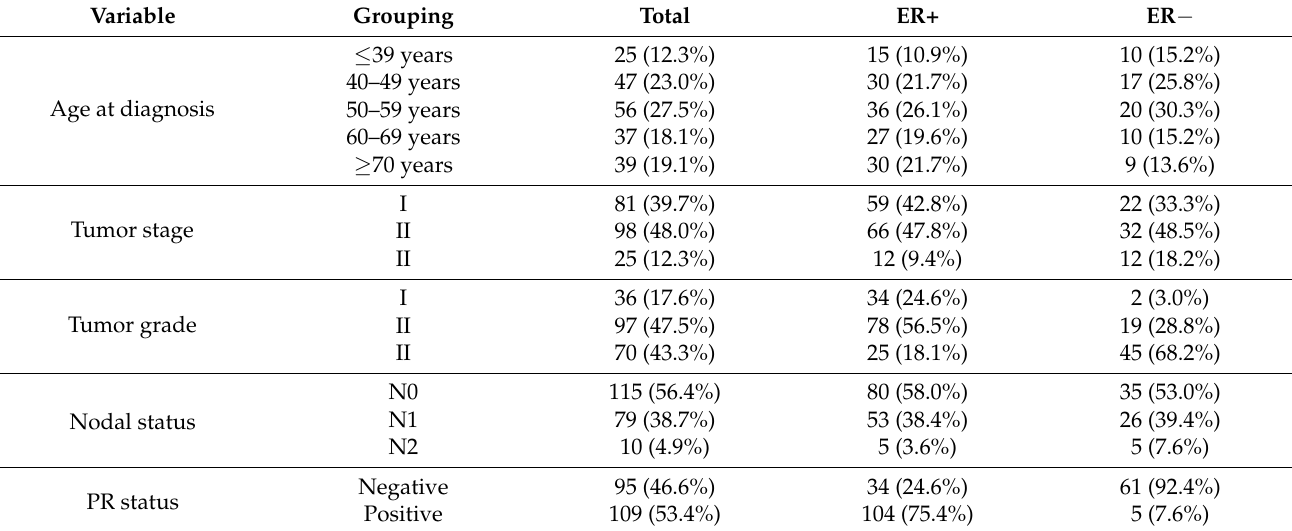
Table 1. Patient